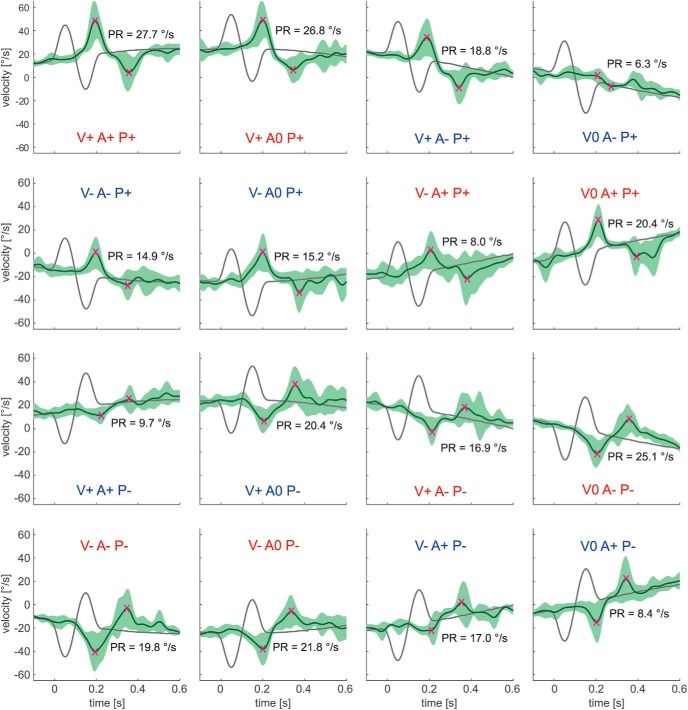
Responses to high-frequency perturbations in an example subject during sinusoidal pursuit. All 16 conditions, as described in Figure 2, are illustrated. Green traces show the averaged eye velocity, with the SD marked light. Dark gray traces show target velocity. Magenta crosses mark peaks and troughs of the PR. For PR determination the carrier was subtracted. The labels for ipsidirectional perturbations are colored red, the labels for contradirectional perturbations are colored blue.